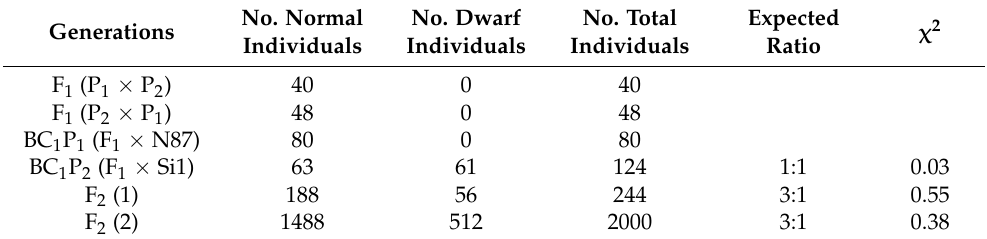
Table 1. Genetic analysis of the dwarf phenotype in CmaSI1